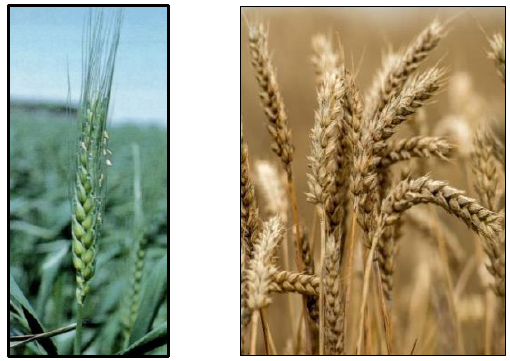
Figure 2. (a) Early flowering stage; green & erect ear (Miller, 1992) (b) Late flowering stage; brown and bent ear (Knapton, 2016).